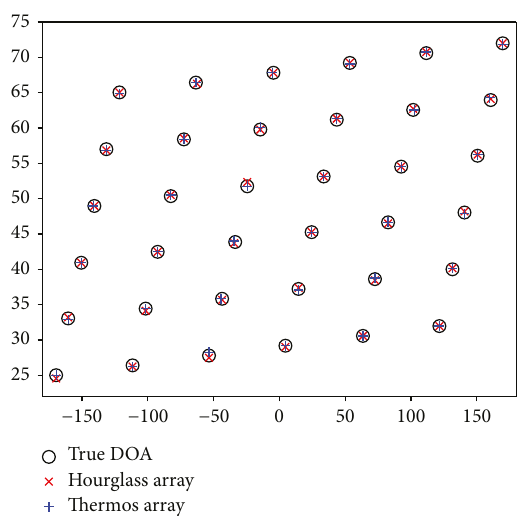
Figure 4: DOA estimation for a single trial of two array geometries.